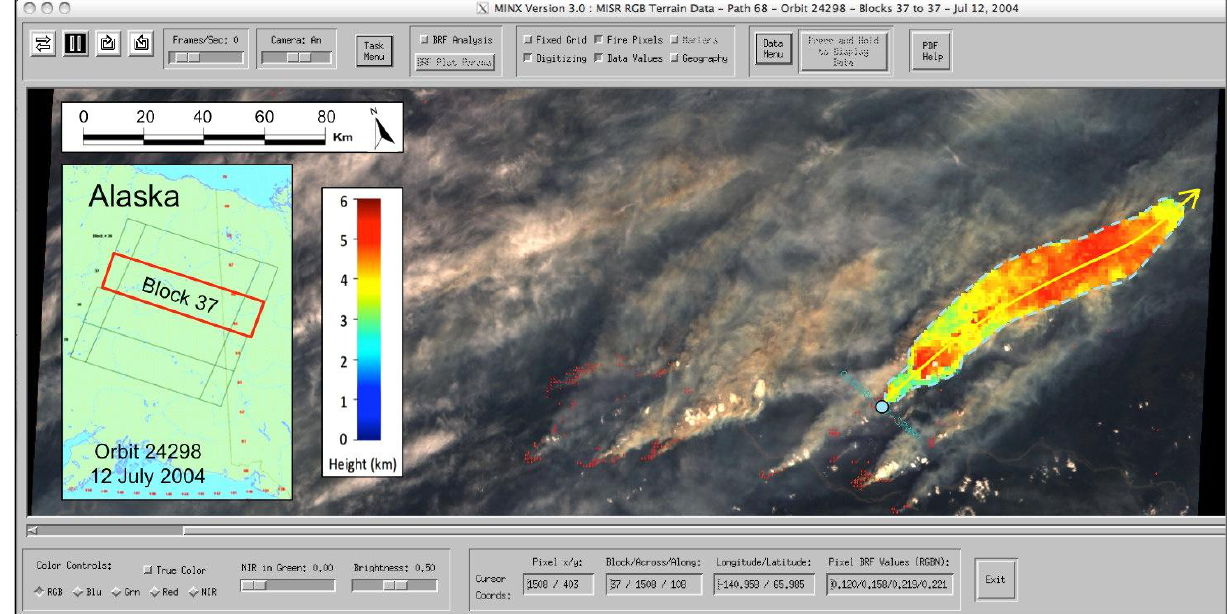
Figure 1. The MISR nadir camera image for orbit 24298, block 37 in the image pane of the MINX animation window after one block of level 1 terrain-referenced radiance data has been loaded, after MODIS thermal anomaly retrievals have been over-posted (red dots) and after wind-corrected heights have been retrieved for one plume (represented by colors inside the plume polygon). The large wildfire plumes on the right half of this image were captured over eastern Alaska on 12 July 2004. Five plumes in this image are associated with fires each producing from 3 to 6 gigawatts of radiative power as measured by MODIS. The dashed, aqua outline of the plume polygon and the yellow wind direction arrow were digitized with a mouse. The color key shows aerosol height above sea